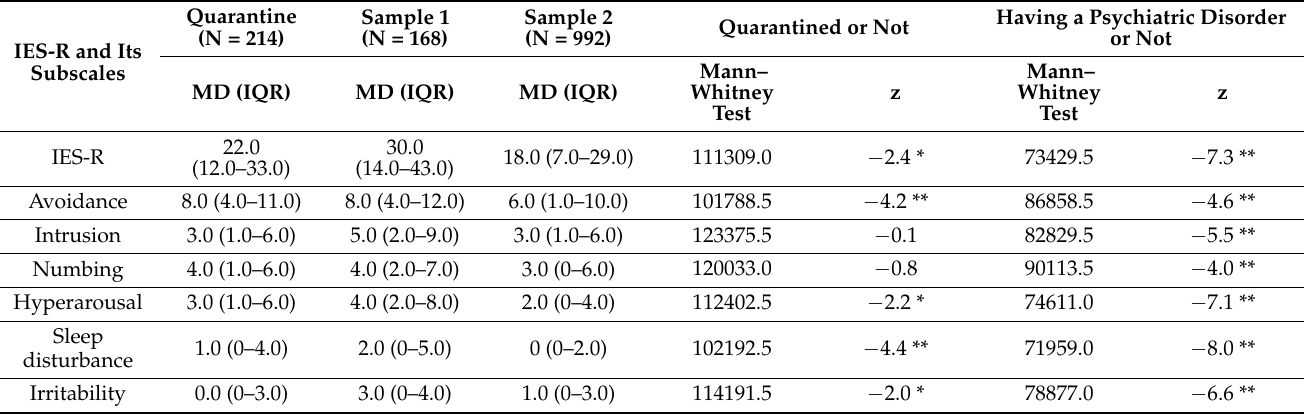
Table 7. Descriptive statistics and known-group validity of the Arabic version of the Impact of Event Scale-Revised (IES-R) and the factors it comprises among quarantined, psychiatric, and healthy